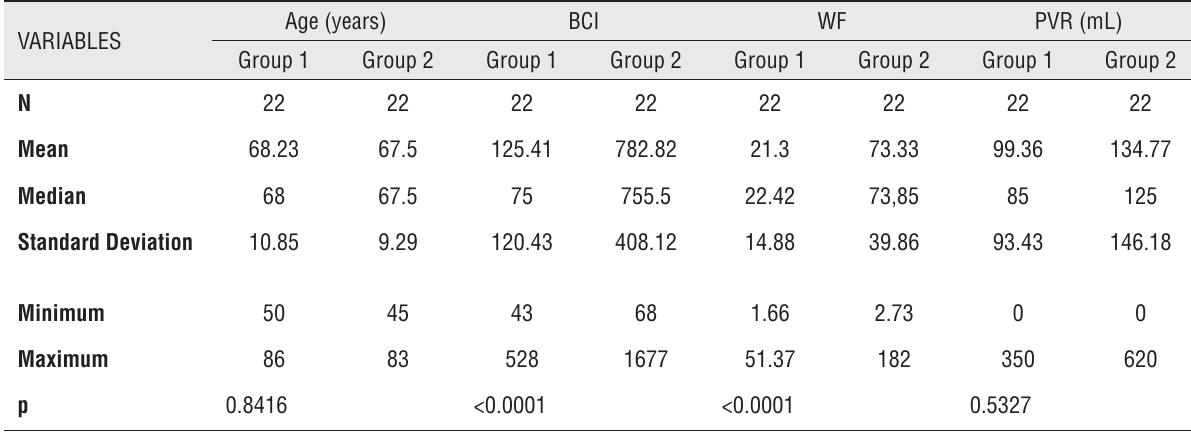
Table 2 - Descriptive and comparative analysis between groups: age, urodynamic data and post void residual; mean, median, standard deviation, minimum, maximum, and confidence intervals were described. There was a significant difference between groups for BCI and WF (p <0.0001; Mann-Whitney